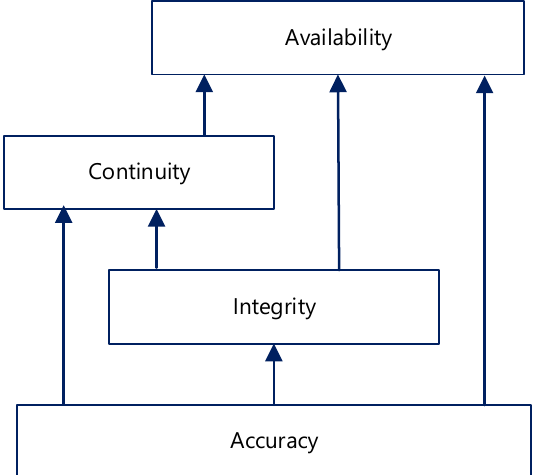
Figure 3. Dependency and hierarchy of GNSS service performance parameters (based on [13]).